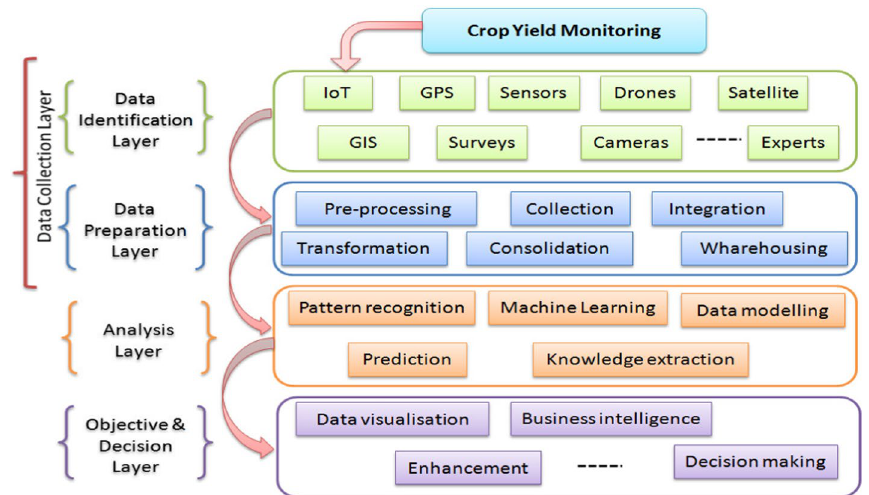
Fig. 5 Big Data Analytics system architecture for crop yield